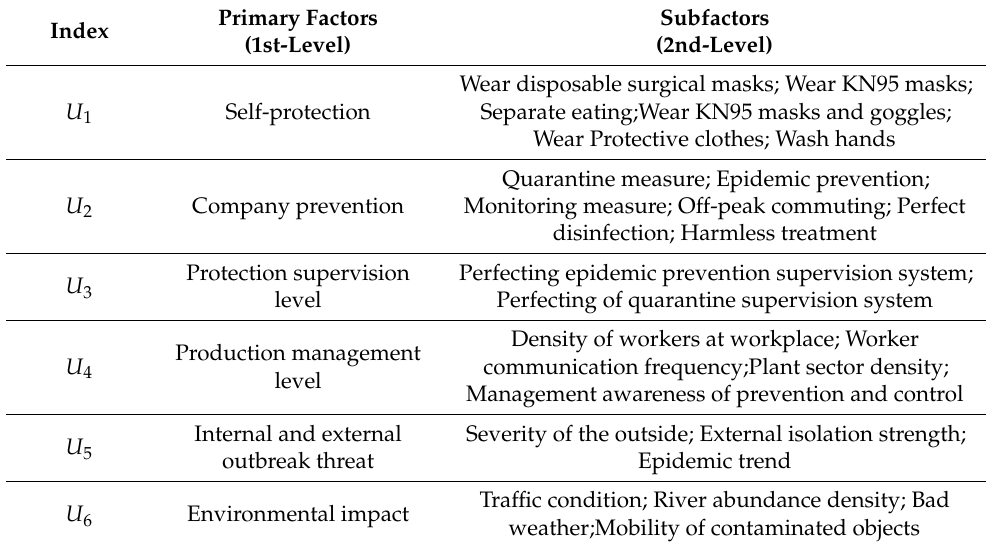
Table 2. The evaluation for the potential outbreak risk (EPOR) of work resumption during